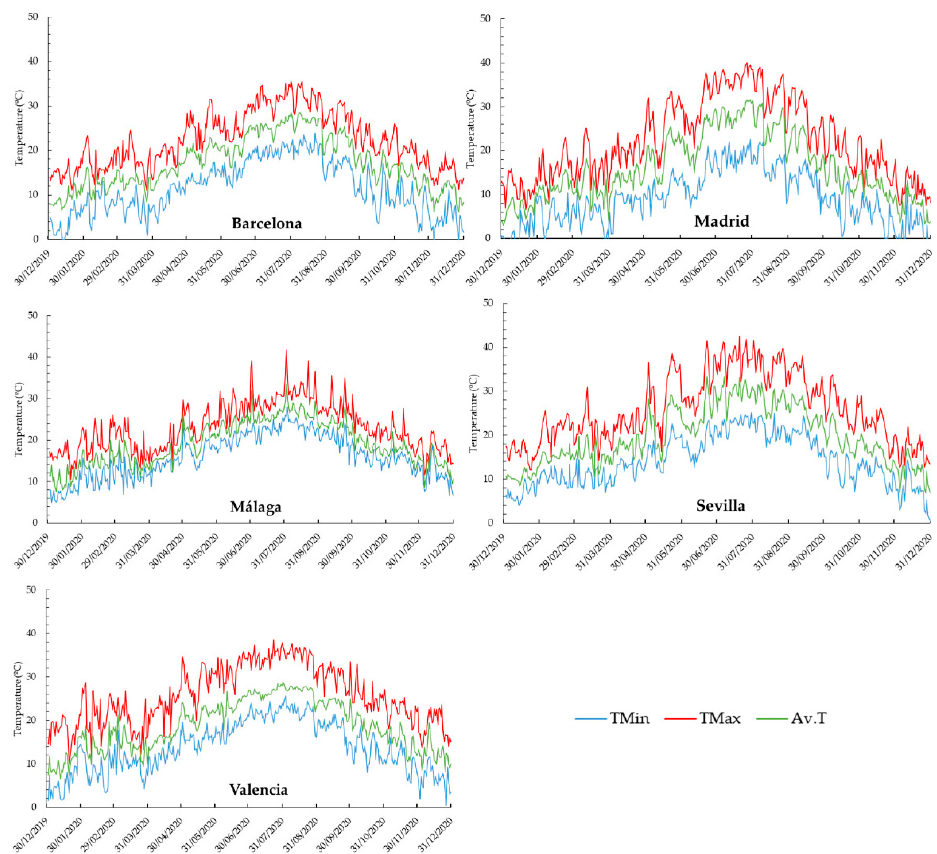
Figure 3. Atmospheric changes during 2020 in Barcelona, Madrid, Málaga, Sevilla and Valencia, depicting the average temperatures (Av.T), maximum temperatures (TMax), minimum temperatures (TMin). Table 1. Comparison of air temperature values (°C) in 2020 for the 10 and 30 year data series. TMax = maximum temperature; TMin = minimum temperature; Av.T = average temperature; and ± = standard deviation. TMin TMax Av. T